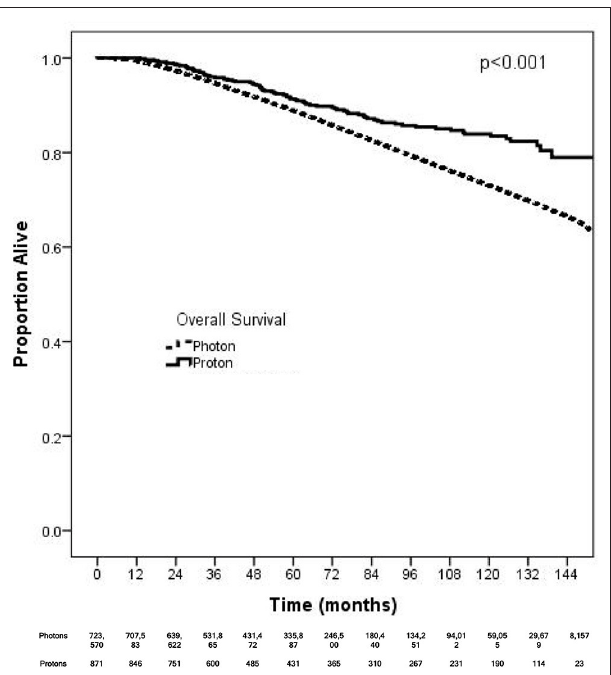
FIGURE 2 | Kaplan-Meier survival analysis of breast cancer patients receiving adjuvant proton and non-proton radiotherapy.